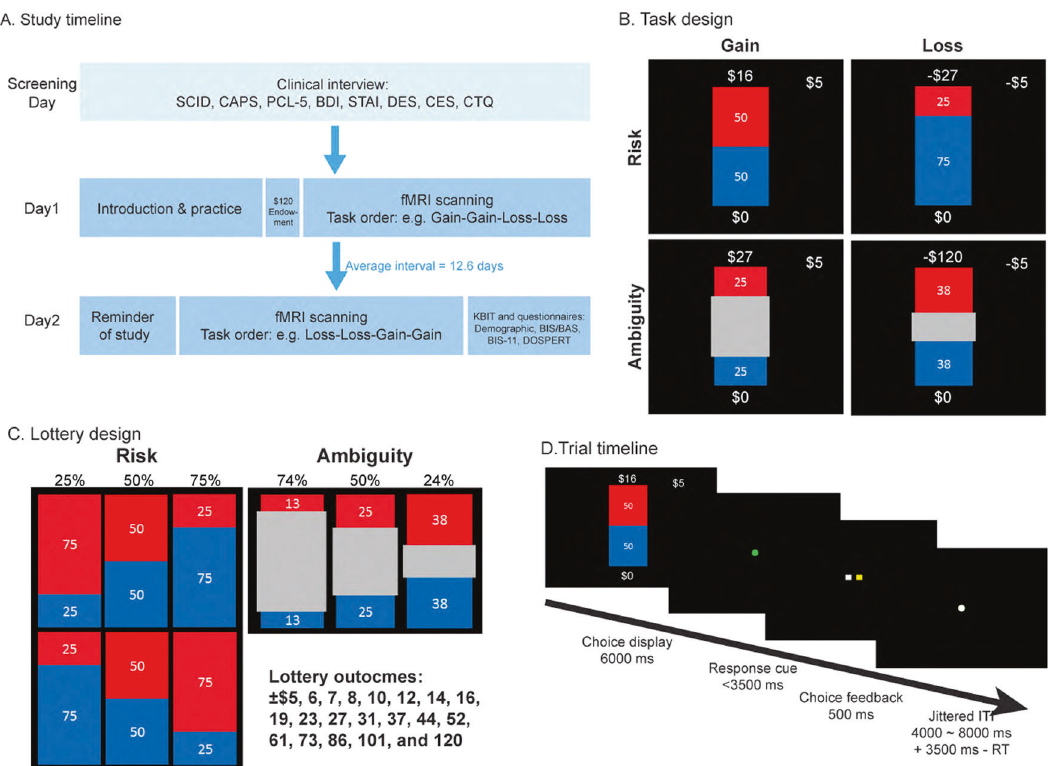
Fig. 1 Study design. A Timeline of the study. Participants went through a screening session and two scanning sessions on three different days. The screening session determined participants ’ eligibility based on PTSD diagnosis, combat exposure, and exclusion of other neurological disorders. Eligible participants were scanned on two separate days on a decision making task. Measure labels: SCID: Structured Clinical Interview for DSM-4, CAPS: Clinician Administered PTSD Scale, PCL5:, PTSD Checklist for DSM-5, BDI: Beck Depression Inventory, STAI: State and Trait Anxiety, DES: Dissociative Experiences Scale, CES: Combat Exposure Scale, CTQ: Childhood Trauma Questionnaire, KBIT: Kaufman Brief Intelligence Test. B Task design: participants chose between a lottery and a sure outcome under four conditions: risky gains, ambiguous gains, risky losses, and ambiguous losses. Lotteries are shown as examples. Outcome probability of the risky lottery was represented by the area of the red or blue rectangle and was fully known to the participant. Outcome probability of the ambiguous lottery was covered by a grey rectangle in the middle, thus was partially known to the participant. C Levels of risk (outcome probability, 25%, 50%, and 75%), ambiguity (grey area, 74%, 50%, and 24%), and monetary outcomes (20 monetary gains and 20 monetary losses) of the lottery. Each unique combination of uncertainty level and outcome level was presented once, for a total of 240 trials. D On each trial, participants had 6 s to view the options, and made a choice following a green response cue. They had a time limit of 3.5 s to register the choice, after which they would immediately see a con fi rmation with the yellow square representing the side they chose. The lottery was not played out during the scan to avoid learning. The inter-trial-interval (ITI) was jittered among 4, 6, and 8 s, and the remaining time during the response window (3.5 s — response time) would be added to the To prevent learning, the outcome of the chosen option was not presented during the scan. Before the fi rst session, participants received an endowment of $120. In the end of the study, one randomly selected trial was realized for bonus payment, which was added to the endowment or subtracted from it. Participants were introduced to the task on Day 1 and were reminded of the instructions on Day 2. In 12 trials, the non-zero lottery outcome was identical to the certain amount (±$5), and one option was clearly better than the other (e.g. a certain gain of $5 should be preferred over a 50% chance of gaining $5). Data from participants who chose the inferior option on >50% of these trials were excluded. MRI scans MRI data were collected with two scanners (due to scanner upgrade) at the Yale Magnetic Resonance Research Center: Siemens 3 T Trio (37 participants, 29 reported) and 3 T Prisma (31 participants, 19 reported), using a 32-channel receiver array head coil. High resolution structural images were acquired by Magnetization-Prepared Rapid Gradient-Echo (MPRAGE) imaging (TR = 2.5 s, TE = 2.77 ms, TI = 1100 ms, fl ip angle = 7°, 176 sagittal slices, voxel size = 1 × 1 × 1 mm, 256 × 256 matrix in a 256 mm fi eld-of- view (FOV)). Functional MRI scans were acquired using a multi- band Echo-planar Imaging (EPI) sequence (multiband 4, TR = 1000 ms, TE = 30 ms, fl ip angle = 60°, voxel size = 2 × 2 × 2 mm, 60 2 mm-thick slices, in-plane resolution = 2 × 2 mm, FOV = 220 mm).